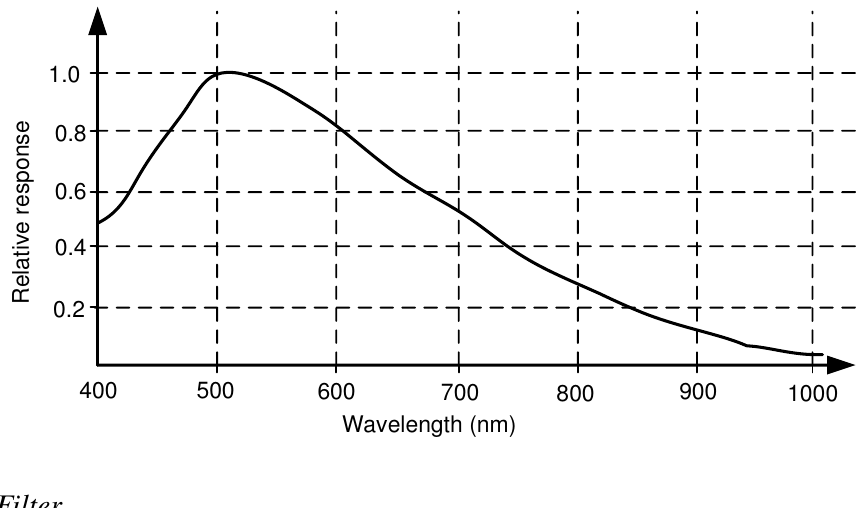
Figure 8. Sensitivity of the camera sensor.